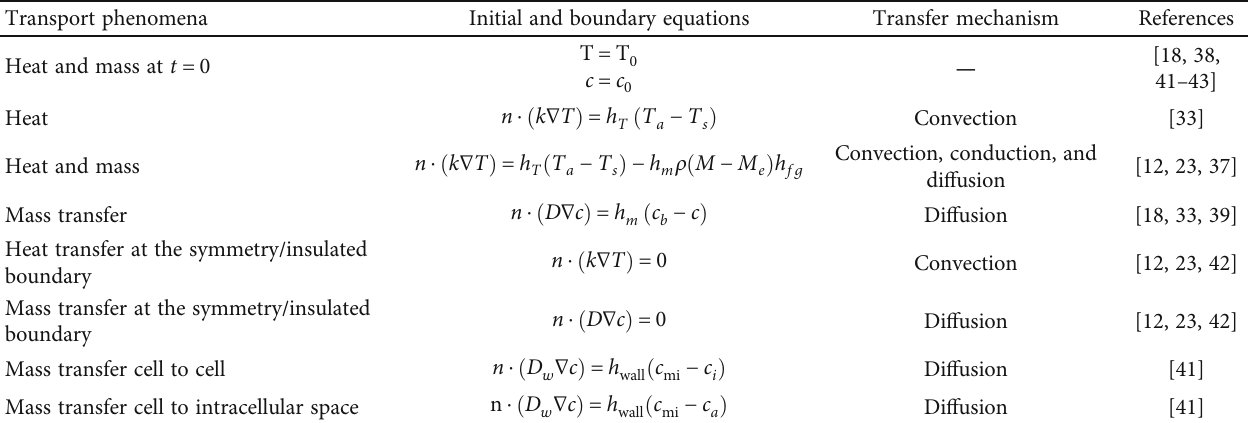
Table 2: Initial and boundary